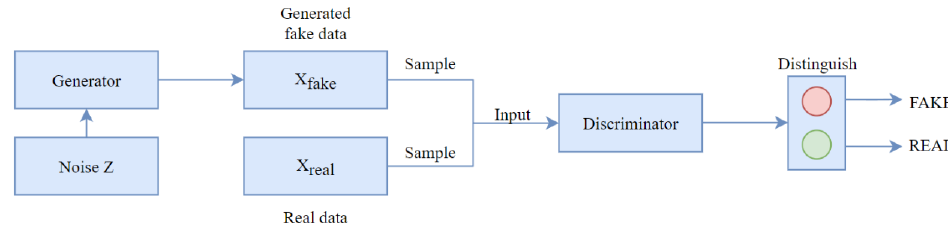
Figure 1. The structure of the